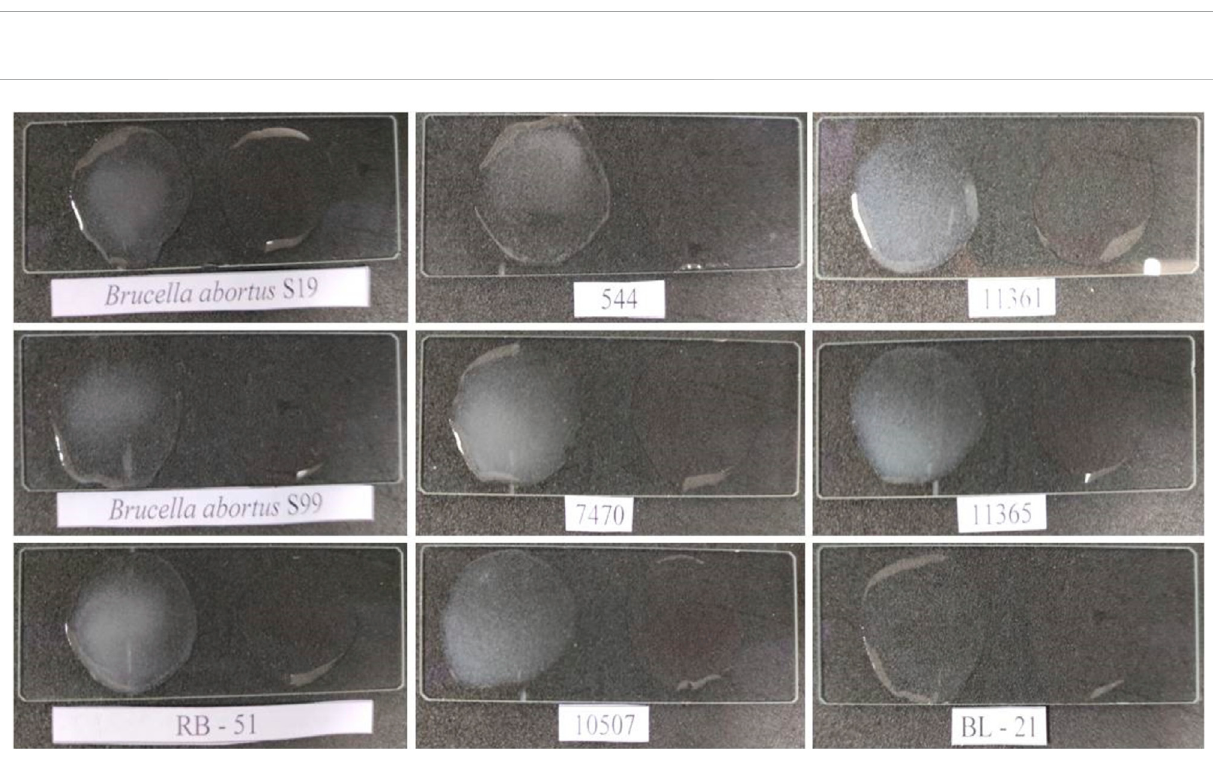
FIGURE 11 Estimation for investigation of test sensitivity of direct-differential slide agglutination assay with WC antigen of Brucella standard strains at an obtained experimentalLODof10 4 CFU mL − 1 with Escherichiacoli (BL-21) and1XPBShavingbioconjugated AuNPswithouttestantigenas anegativetest control ( “ Test Negative ” ). A rapid and strong agglutination reaction with all Brucella standard strains/biotypes was observed, and the results wereinferred as “ Test Positive ” for the developed assay. No agglutination was observed with the test negative Escherichia coli and